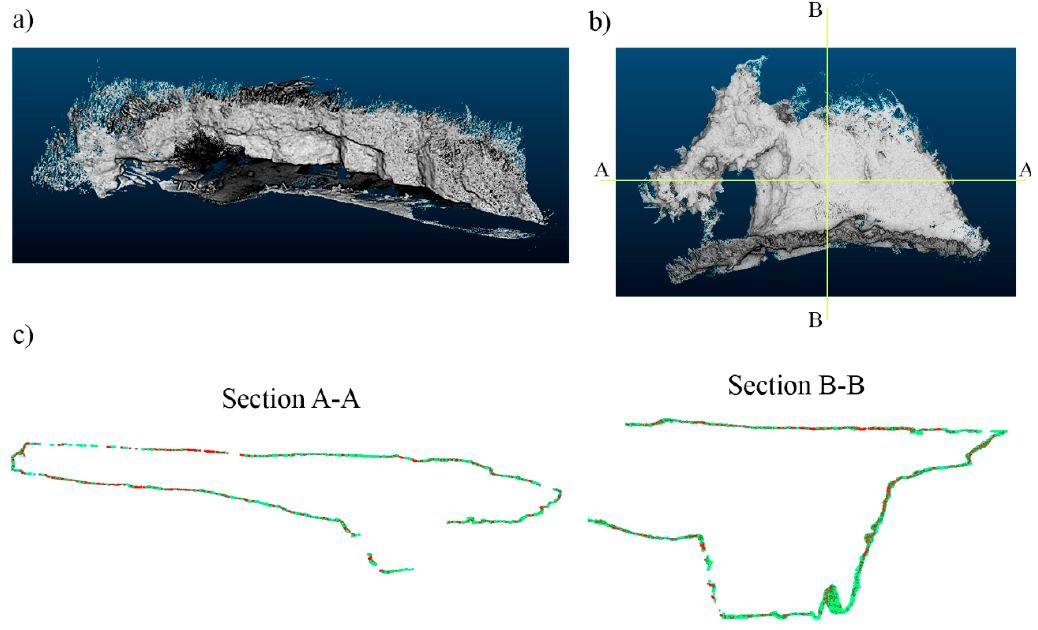
Figure 9. WMLS point cloud: ( a ) general view; ( b ) plant view and; ( c ) comparison between the TLS and the WMLS point clouds—the TLS point cloud is in green and the WMLS point cloud is in red.